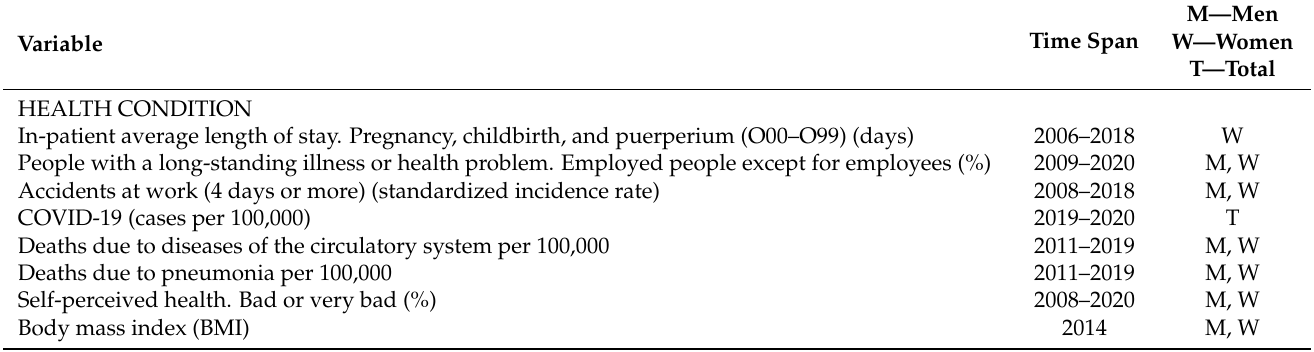
Table 1. Potential determinants of absenteeism in men and